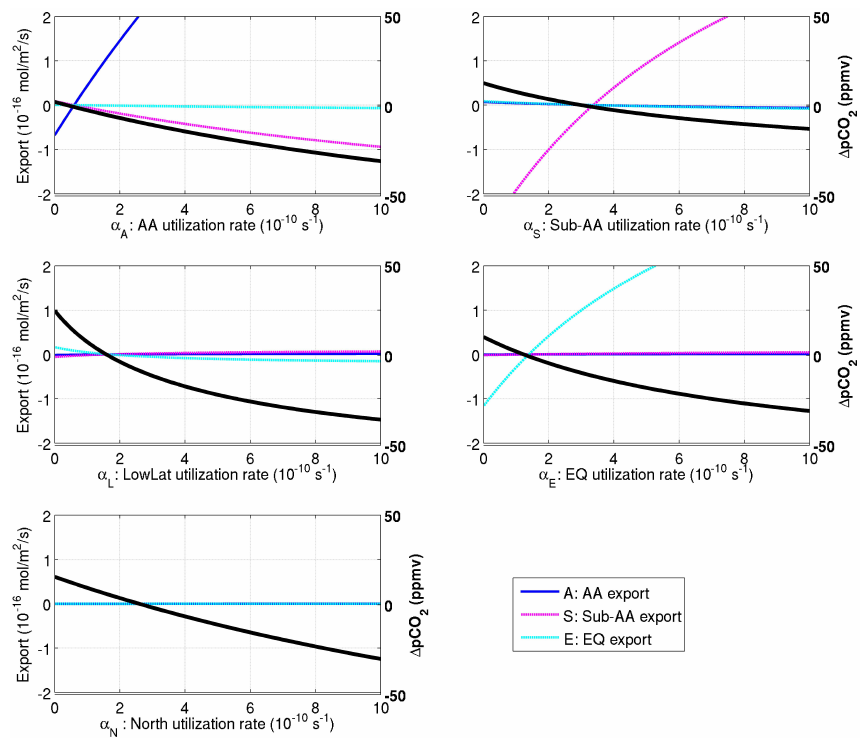
Fig. 6. Same as Fig. 5 but here the sensitivity of the export production and 1p CO 2 to the nutrient utilization rate parameters are